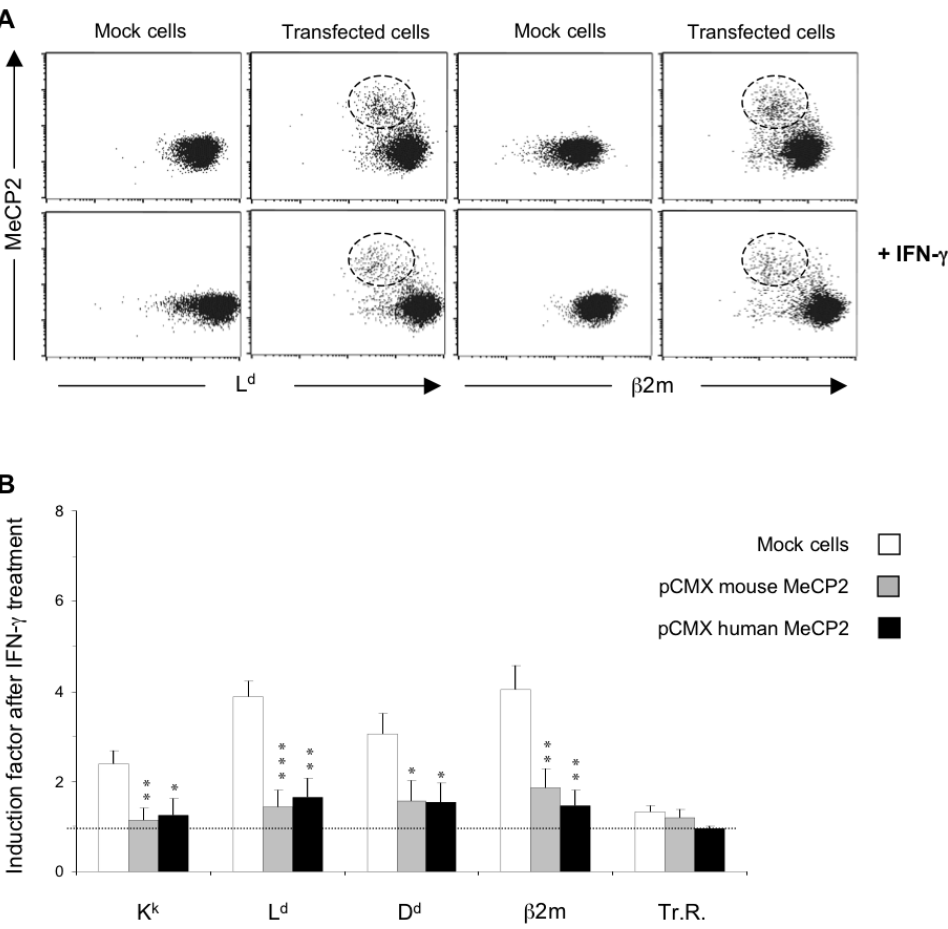
Figure 2. Transient overexpression of MeCP2 inhibits MHC class I induction by IFN- c . N2A cells transfected with pCMX vectors expressing murine or human MeCP2 were treated or not with IFN- c for 48 hrs and then double immunostained for cell surface b 2-microglobulin, transferrin receptor or MHC class I and intracellular MeCP2. Panel A: Dot-plots of transfected cells analysed by flow cytometry showing the cell surface level of the MHC class I molecule L d or b 2-microglobulin (x-axis) plotted against the level of intracellular MeCP2 (y-axis). Panel B: The induction factor was calculated as the ratio of MFI of treated cells (over-expressing MeCP2 or untransfected cells) on MFI of untreated N2A cells. Values used for the histogram are the mean ( 6 SEM) of induction factors obtained in seven independent transfection experiments. Statistical significance of difference between groups was analysed by using an unpaired t-test (*, p , 0.05; **, p , 0.01; ***, p , 0.001).